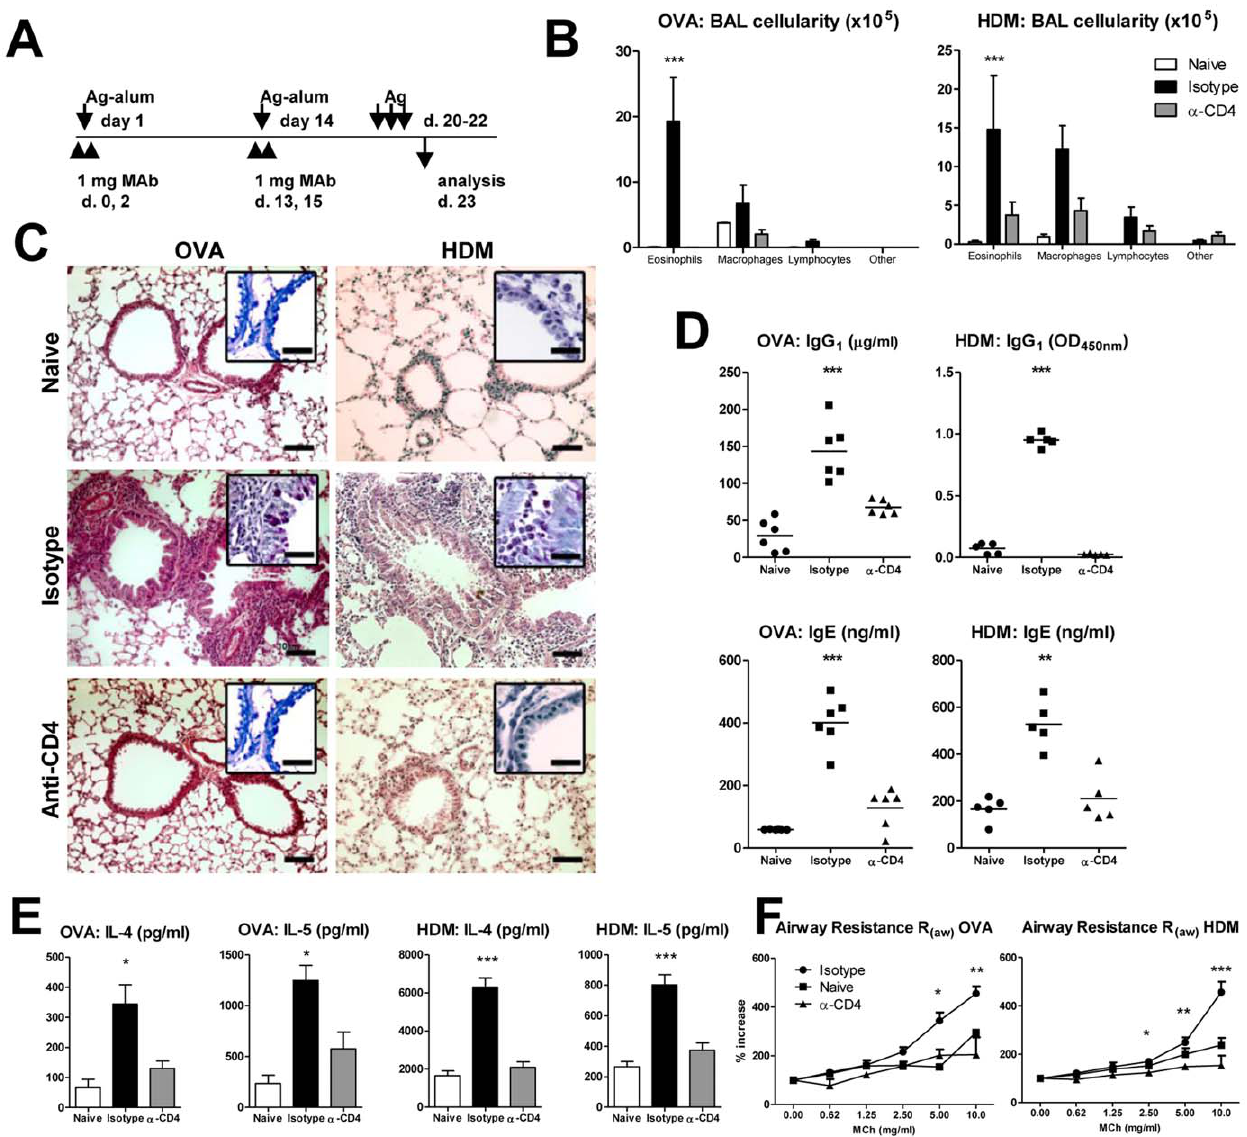
Figure 1. Prevention of allergic sensitization with anti-CD4 MAb. (A) Female BALB/c mice were sensitized with 20 m g OVA-alum or 50 m g HDM-Alum i.p. and challenged with 50 m g OVA or HDM in saline i.n. on the indicated days. Some animals were treated with 1 mg anti-CD4 or an isotype control i.p. as shown. Naive mice, not subjected to any intervention, were also studied as a control group. (B) Cellular composition of the BAL. Animals treated with anti-CD4 have less eosinophils in the BAL (n=6, *** P , 0.001). (C) Histological sections of lung tissue were stained with hematoxilin/eosin and PAS (inset). Anti-CD4-treated mice have reduced inflammatory infiltrate and goblet cell hyperplasia, to levels similar to naive controls. Bars represent 10 m m (2.5 m m in the inset). (D) Quantification of serum OVA- and HDM-specific IgG1 and IgE. Anti-CD4 MAb treated mice show a significant reduction of the Th2-driven immunoglobulins (n=6, *** P , 0.001 and ** P , 0.01 as indicated). (E) The Th2 cytokines IL-4 and IL-5 were down to basal levels in lung homogenates of anti-CD4 treated mice (n=6, * P , 0.05 and *** P , 0.001). (F) Invasive measurement of respiratory mechanics shows that animals treated with anti-CD4 MAbs had reduced airway resistance to increasing doses of inhaled MCh, when compared with sensitized control animals (n=8). Data (B–F) are representative of at least three independent experiments.